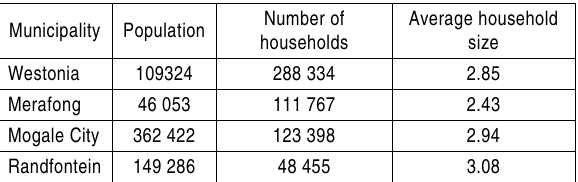
Table 1. Composition of West Rand district municipalities and their population